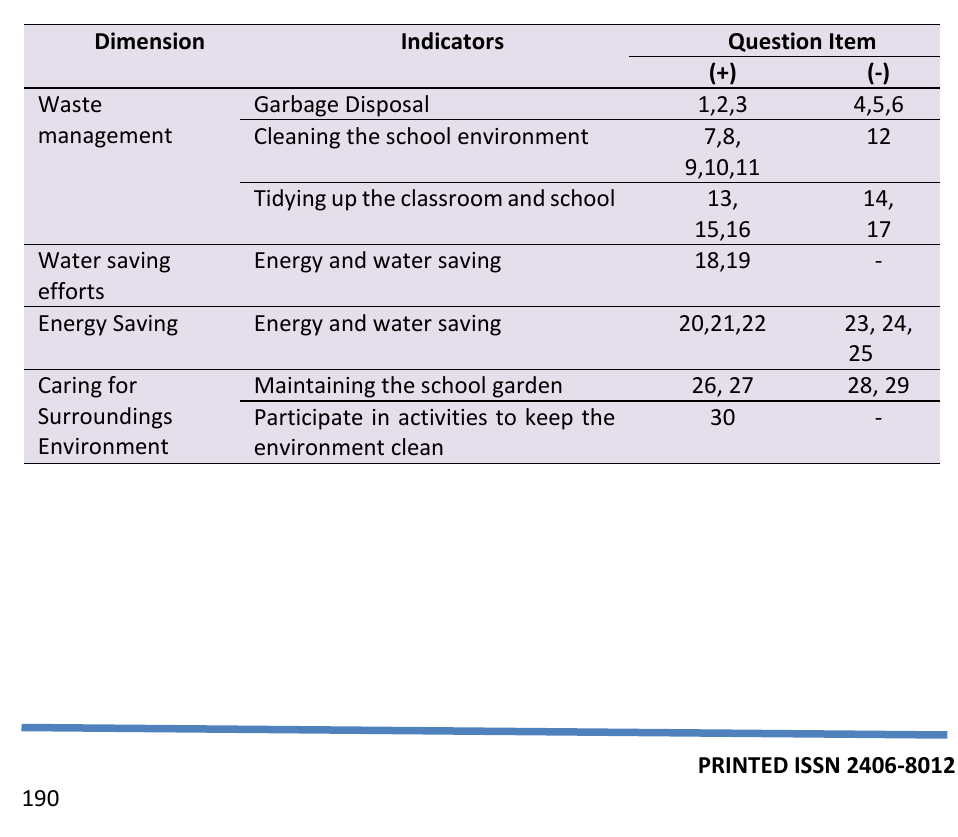
Table 1 . Instrument of Environmental Care Character